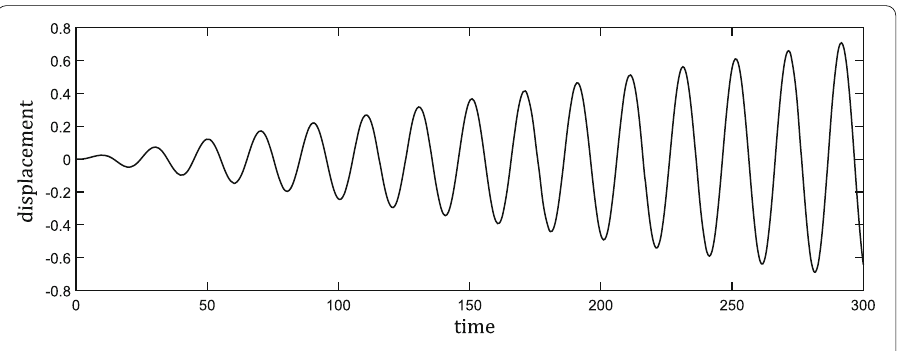
Fig. 8 Vertical displacement in the free end of the cantilever beam under force: